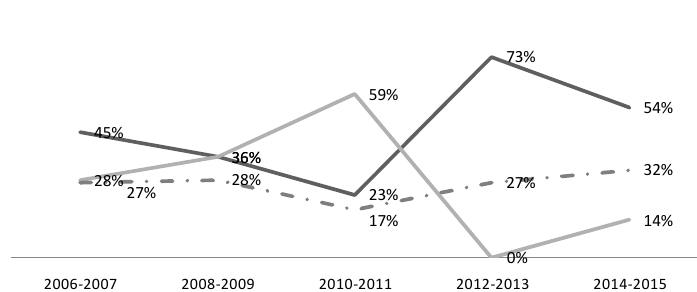
Figure 7. The dynamics of output-biased technical change.